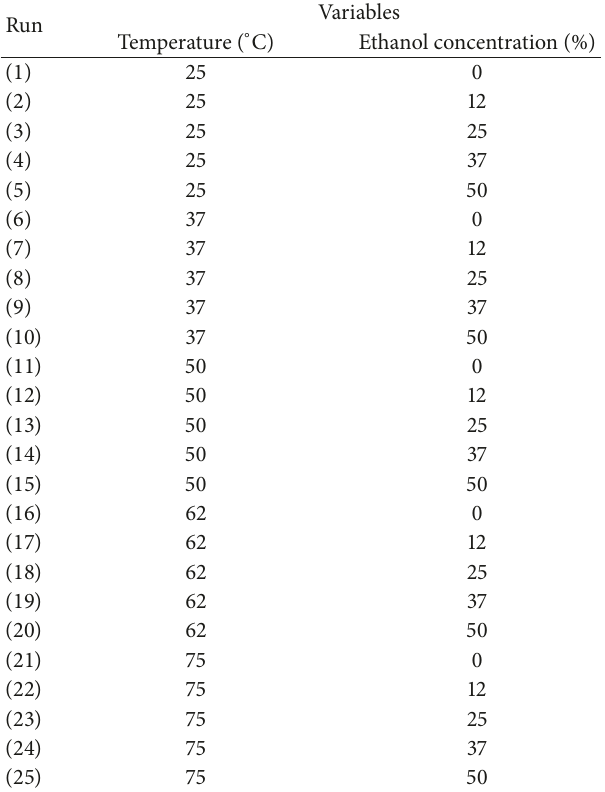
Table1:Theexperimentalpointsofeachvariableforthesolid-liquid extraction of polyphenols from apricot